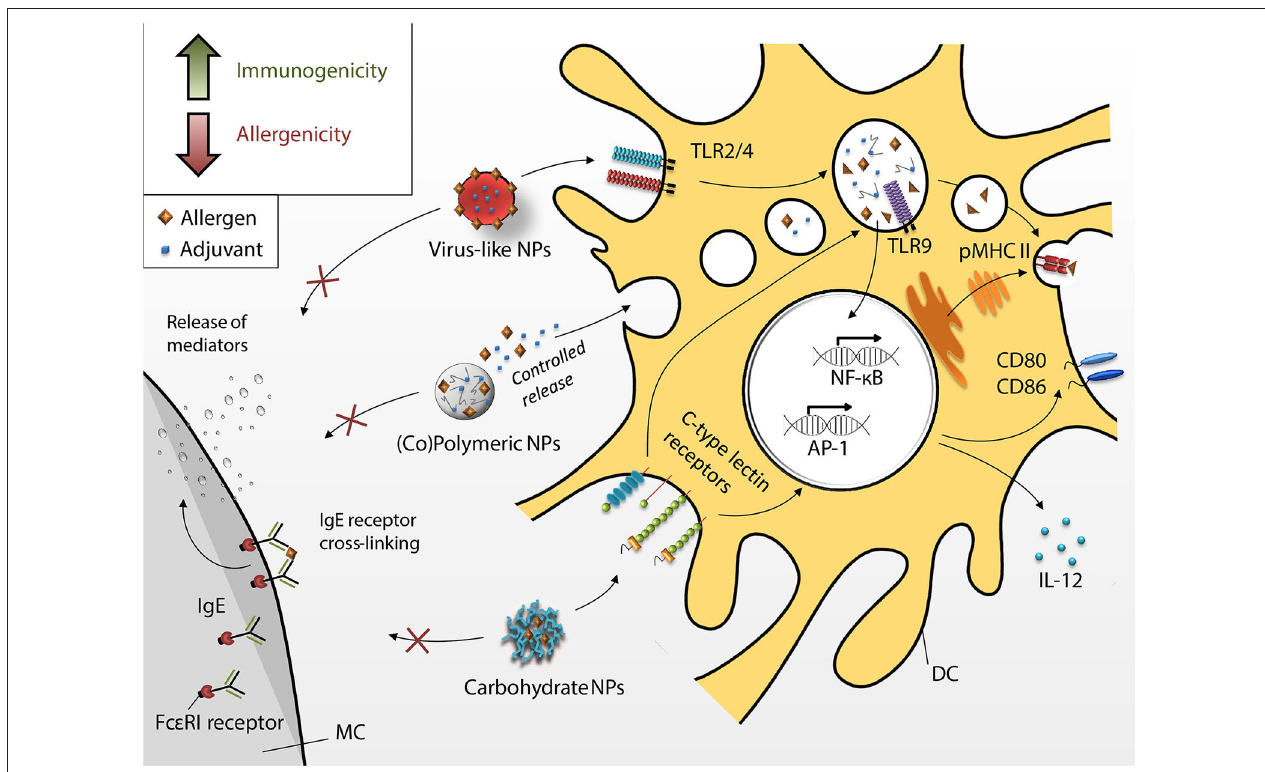
FIGURE 4 | Dendritic cell-targeting by different nanoparticles. Novel approaches intend to increase immunogenicity (green arrow in box) and decrease allergenicity (red arrow in box) of the nano-fromulated vaccines (i.e., virus-like NPs, copolymer, and peptide-based polymeric NPs and carbohydrate NPs) taken up by DCs through receptor-mediated phagocytosis. Allergen encapsulation and increased uptake shall render vaccines hypoallergenic (i.e., inhibition of MC degranulation, red arrow in box) and more immunogenic (green arrow in box), hence, improving the overall efficacy of